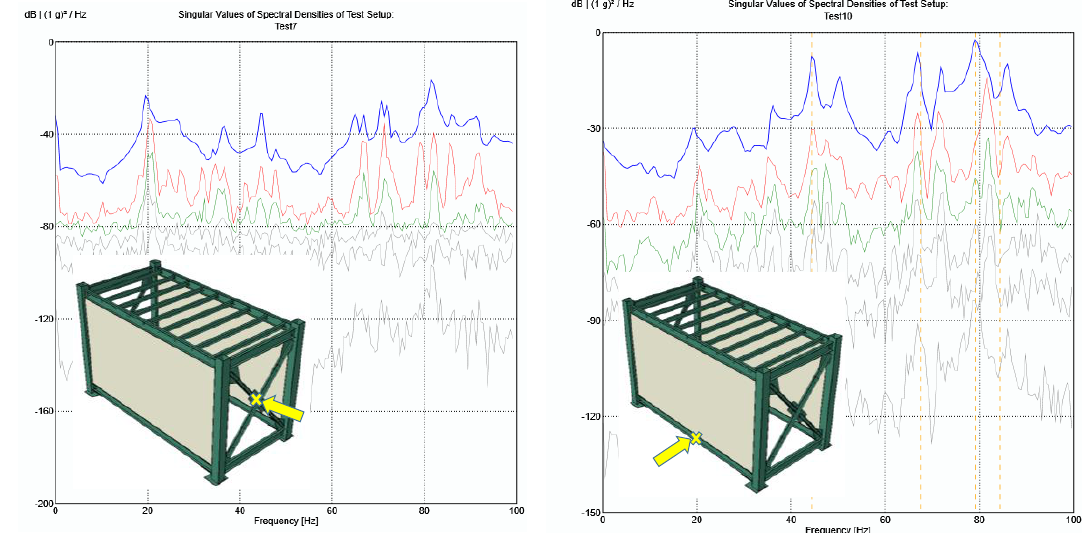
Figure 11. SVD diagrams of the recorded accelerations during two hammer impact tests on the EE test case. Table 2. Identified frequencies and modal damping ratios. The EFDD method. Bare Module Test Case II Test Case IE Test Case EE Concurrent Mode Freq.